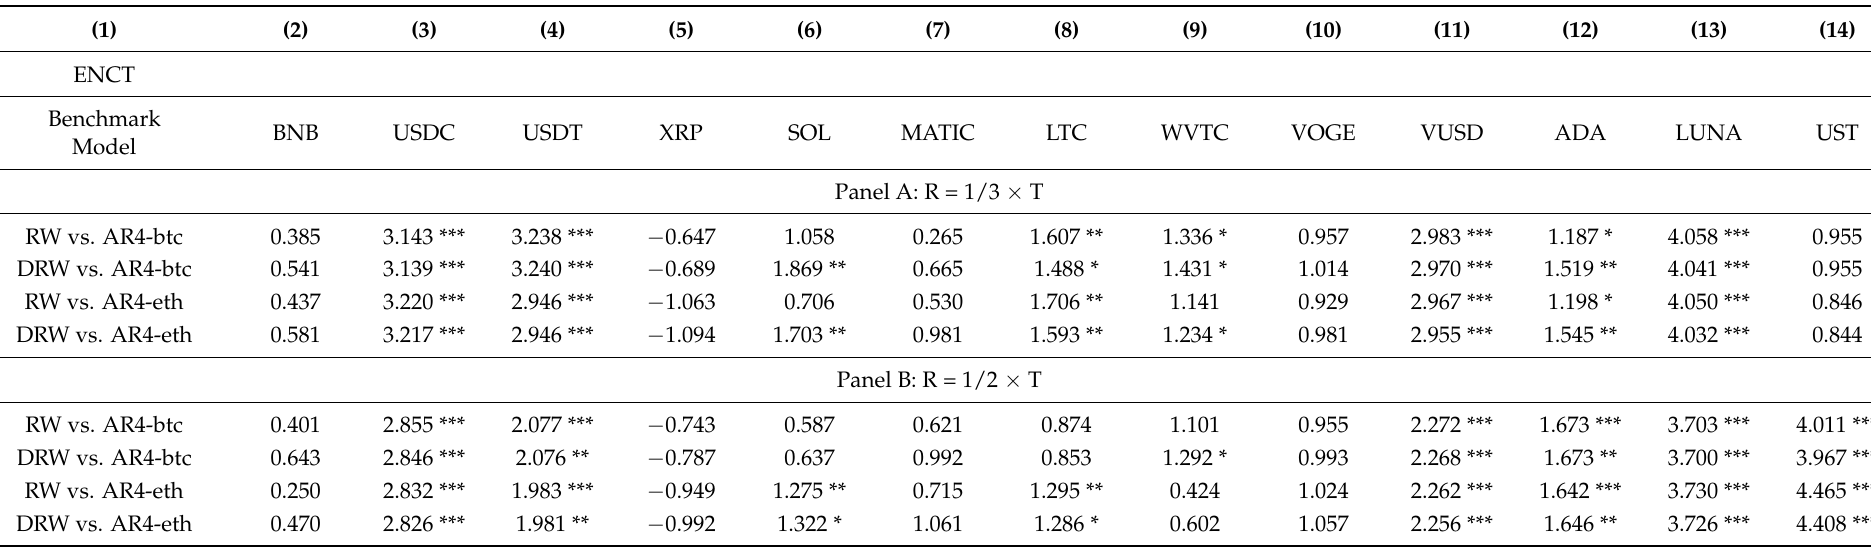
Table 4. The out-of-sample results using the encompassing t-test (ENC -t ) for the different benchmarks and estimation